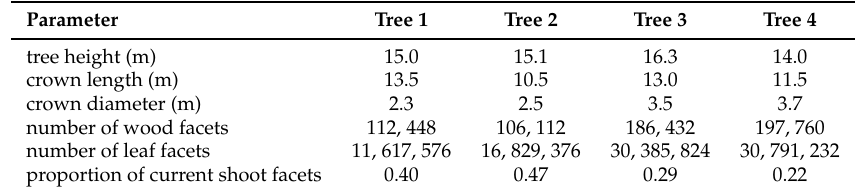
Table 4. Structural characteristics of the four reconstructed 3D spruce trees (Figure 6) populated with complex needle shoot objects (leaf area index = 12 m 2 m − 2 ).